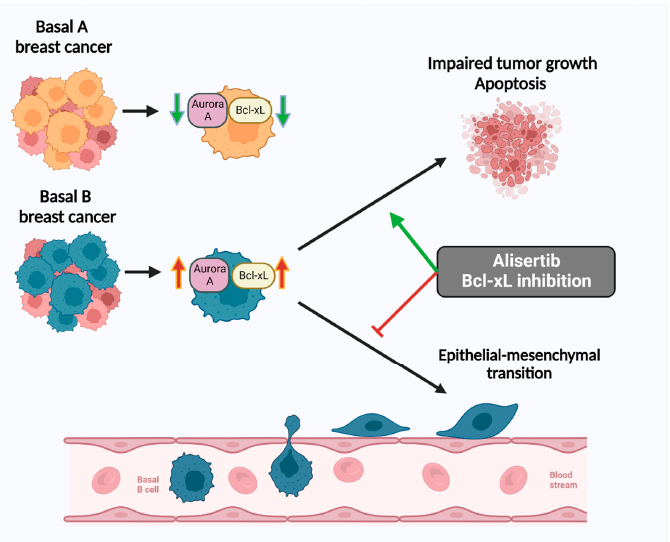
Figure 5. Inhibition of Aurora A with alisertib and blockage of Bcl-xL reduces invasion of basal B breast cancer cells. A schematic presentation showing the role of Aurora A and Bcl-xL in regulating basal B cell growth and metastatic capability (created with BioRender.com, Toronto, ON, Canada). 2.3. High AURKA and BCL2L1 Expression Correlates with Poor Clinical Outcome in TNBC To investigate the prognostic value of Aurora A and Bcl-xL in cohorts of TNBC patients,